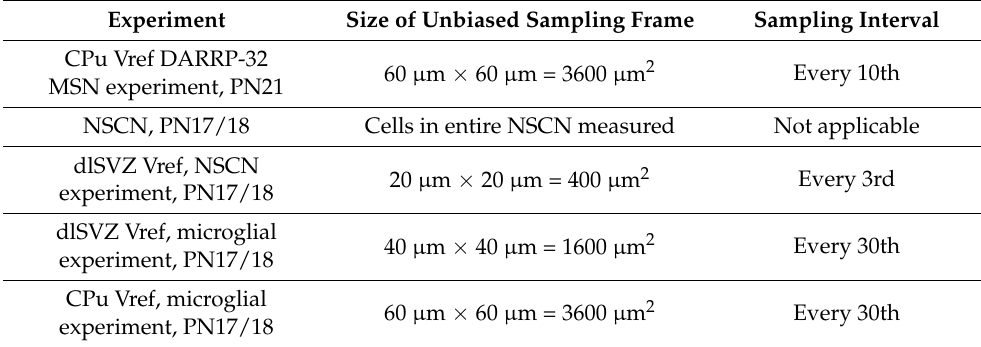
Table 2. Stereological parameters used to measure the Nv of each cell type of interest.